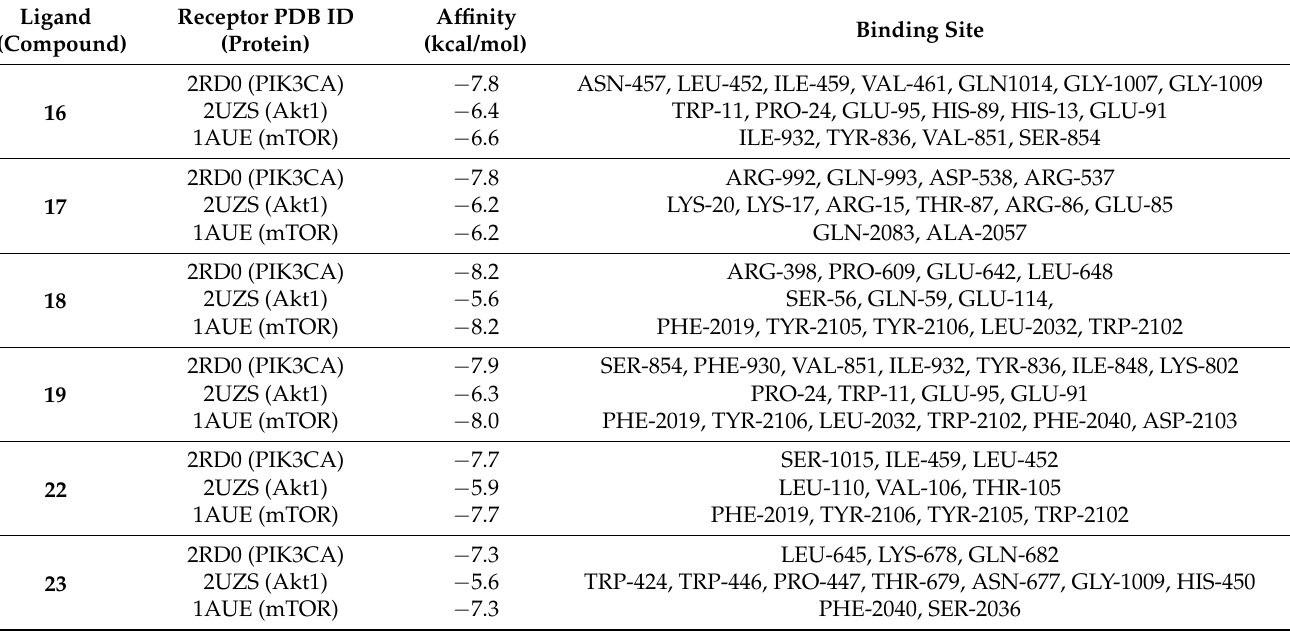
Table 3. Molecular docking parameter